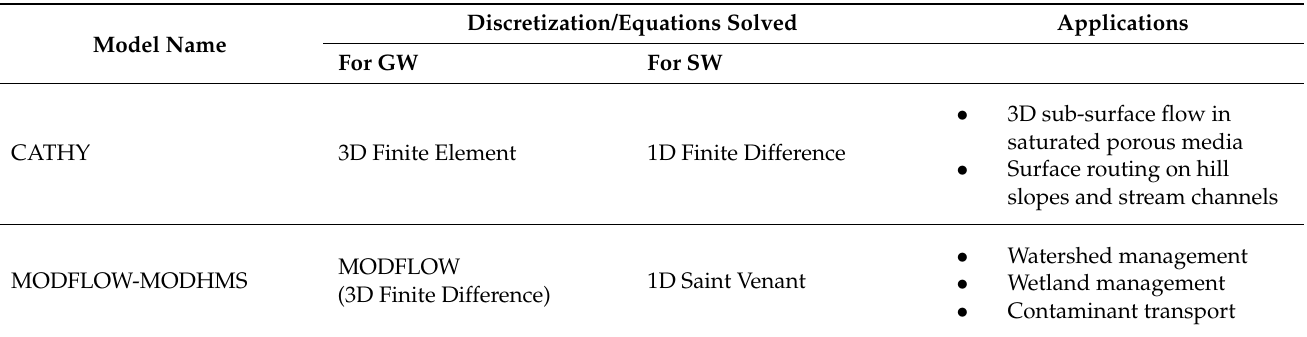
Table 1. Some common models used for GW–SW interaction